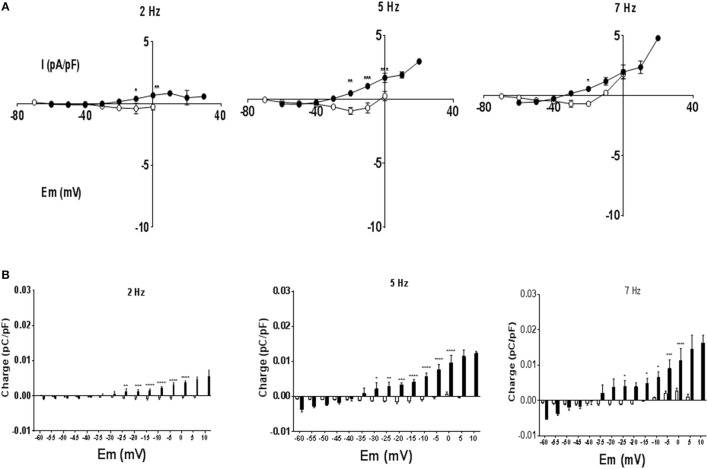
The experimental protocol described in Figure 4 was repeated following exposure to BAPTA. (A) BAPTA abolished inward currents at early repolarization potentials (see Figure 4) to reveal a net outward current at these potentials. (B) There was little charge movement in CON cells but outward charge at positive membrane potentials in MCT myocytes. n = 4 CON and 3 MCT myocytes exposed to BAPTA ****P < 0.0001, ***P < 0.001, **P < 0.01, *P < 0.05 CON vs. MCT two way RM ANOVA.